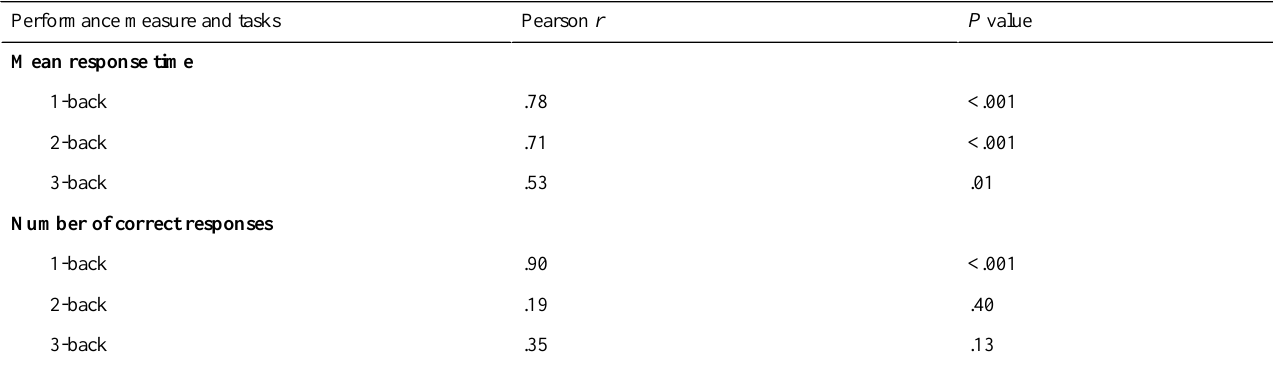
Table 2. Correlation analysis between performance measures of the N-back tasks in the Letter test and PsyToolkit N-back test.